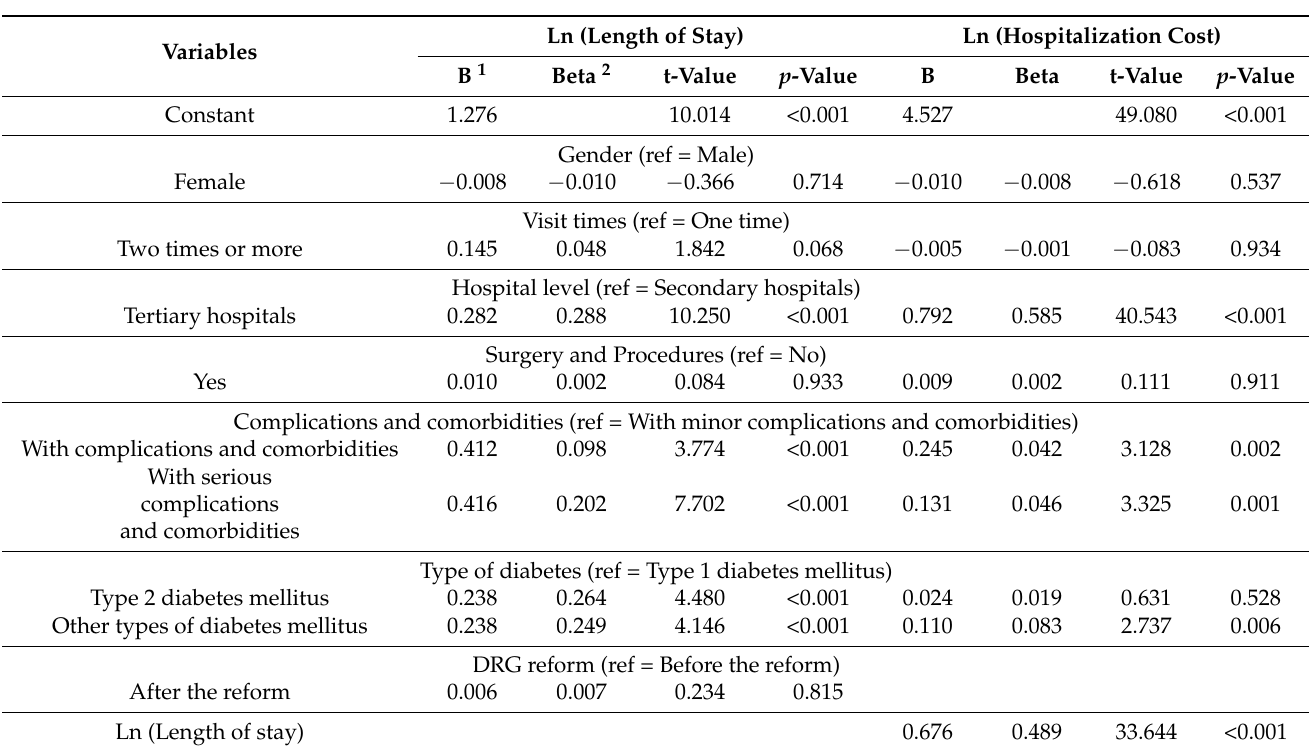
Table 3. Multiple linear regression results in the length of stay and hospitalization cost of diabetic